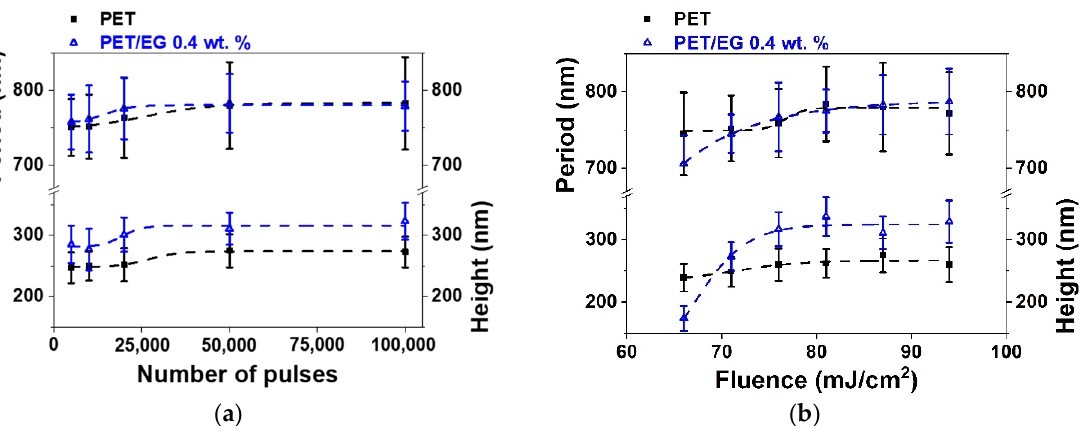
Figure 4. Heights and periods of LIPSS induced on thin-film sample surfaces supported by PET silicon ( (cid:4) ) and PET/EG 0.4 wt.% ( ∆ ) as a function of: ( a ) the number of pulses at a constant fluence of 87 mJ/cm 2 ; and ( b ) fluence at a constant pulse number of 50,000. Laser irradiation was performed at a wavelength of 795 nm. Dotted lines are displayed as visual guides. The data shown correspond to the average and standard deviation of 50